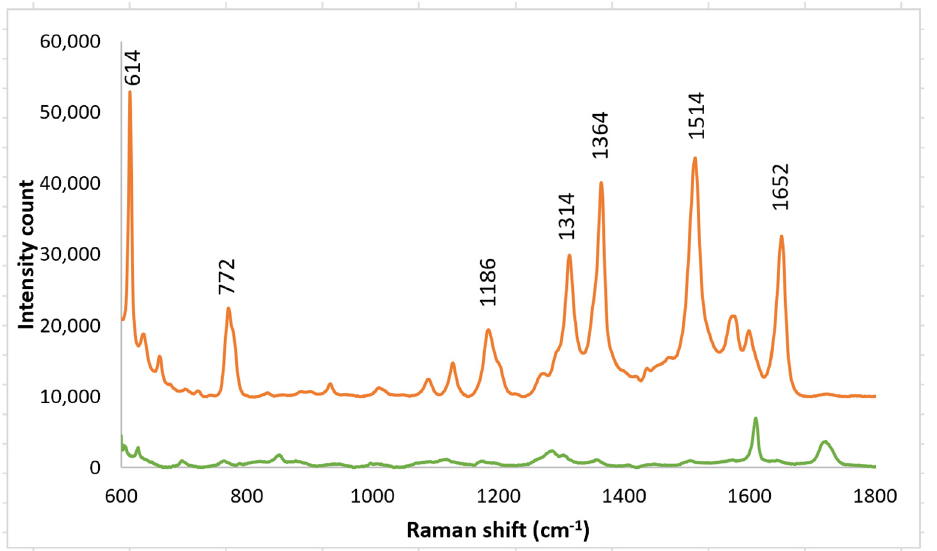
Figure 8. Top trace, 1 mm R6G spectra after drop casting nano-sphere suspension on imprinted PETE-1. Bottom trace, 1 mmol R6G spectra after drop casting nano-sphere suspension on PETE-1 that was not imprinted.